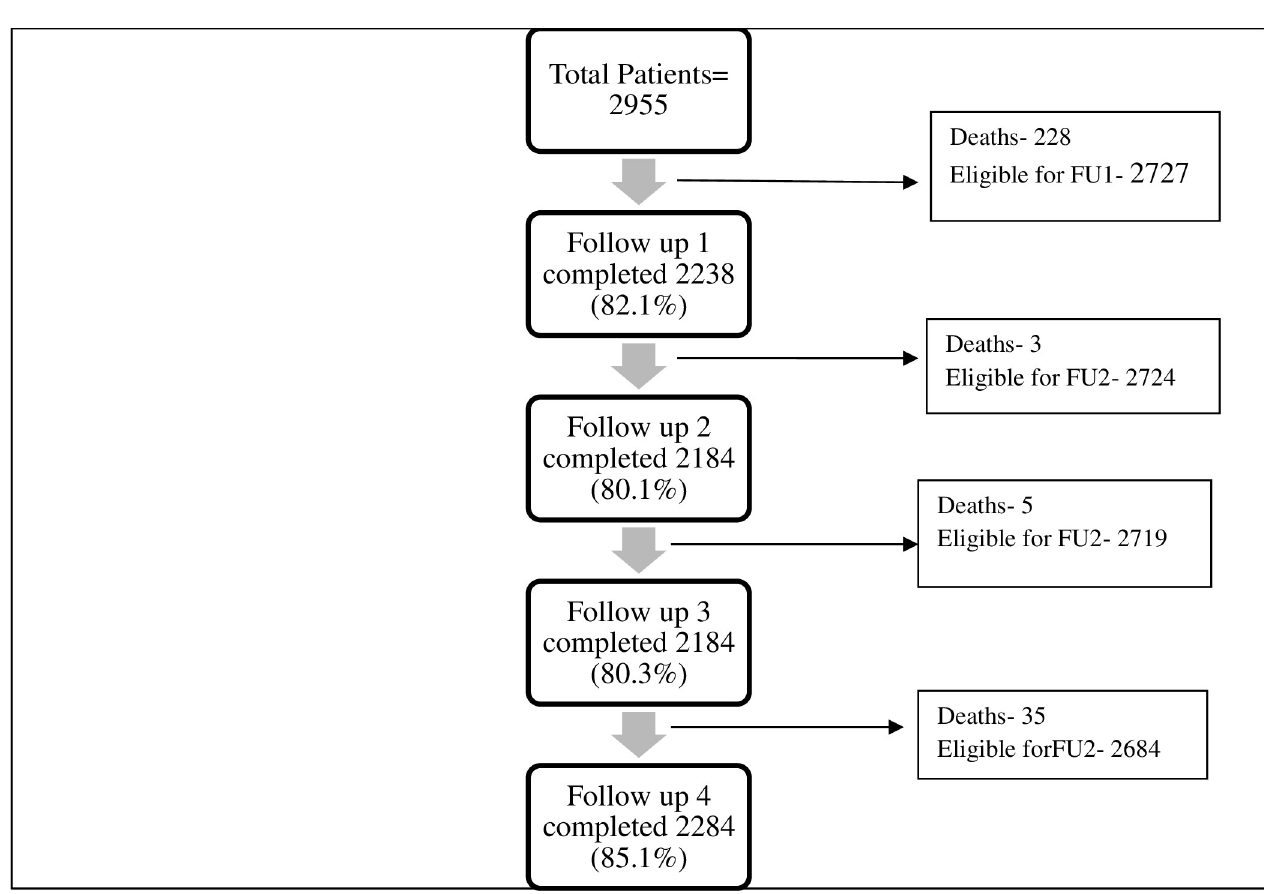
Fig 1. Flowchart showing follow-up (FU)